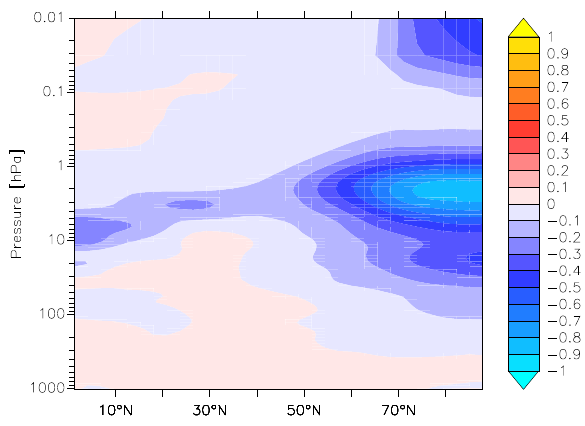
Fig. 8. Climatological DJF change (µmolmol − 1 ) of ozone, 1 O 3 = − O S − noEPP O S − EPP . Red-yellow/blue colours indicate posi- 3 3 tive/negative